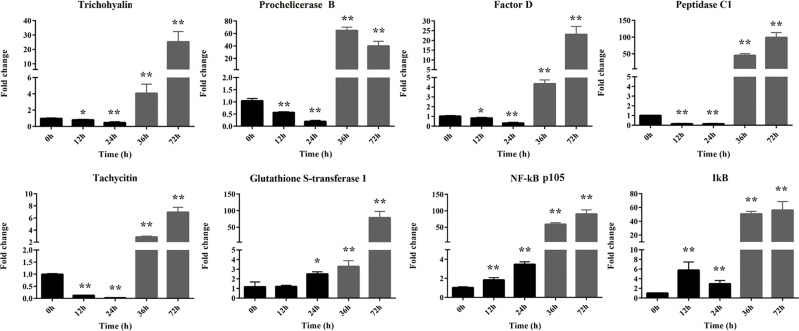
The relative expression levels of eight selected DEGs identified by qRT-PCR. These genes including five down-regulated genes (trichohyalin, Factor B, Factor D, peptidase C1, and tachycitin) and three up-regulated genes (glutathione S-transferase 1, NF-κB p105, and IκB). 18S rRNA was used as the internal reference. Each experiment was executed in triplicate. Data are shown as mean ± SD (N = 3). The asterisk indicates significant difference (**P < 0.01, *P < 0.05) compared with the control (set as 1).